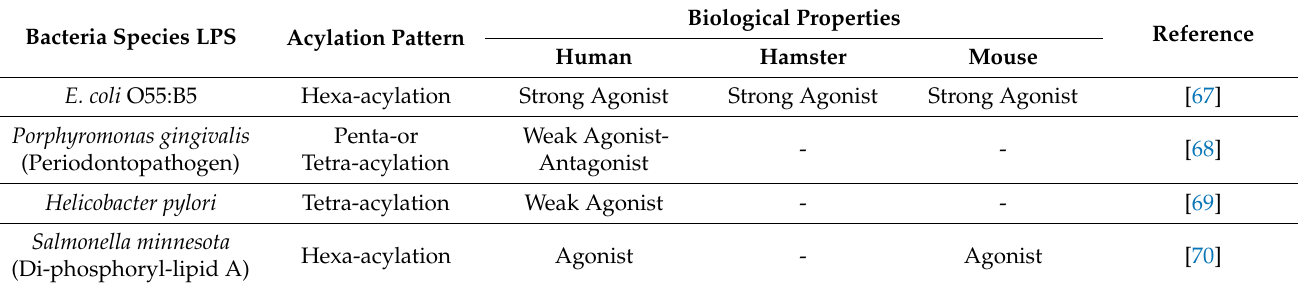
Figure 1. Diagram of the general structure of lipopolysaccharides of Gram-negative bacteria. Lipopolysaccharides of Gram-negative bacteria consist of three main subunits (from bottom to top): lipid A, the core region, and the O-antigen. Lipid A and the core (Adapted from Steimle, A. et al. [66]). Table 1. Acylation patterns of Lipid A moieties from different bacteria. The greater the number of acyl chains indicates stronger immunogenicity of the respective lipopolysaccharide (LPS) molecule.